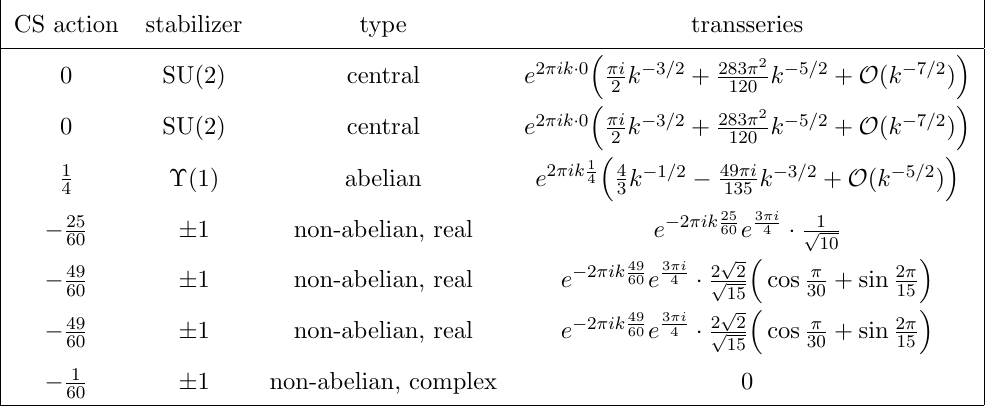
1; 1 ; 1 ; 1 2 3 10 (cid:0)